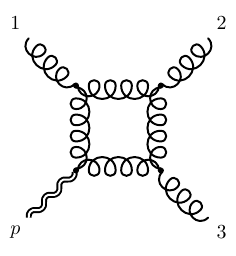
Figure 14 . The box graphs in the three-gluon amplitude at order κg 3 given by (5.12).